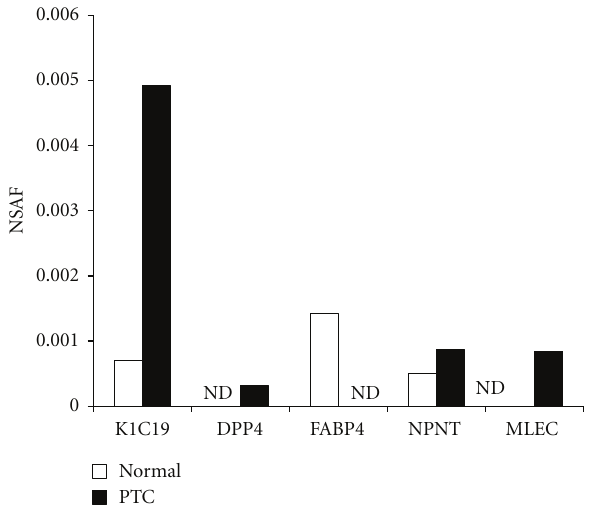
Figure 2: Comparison of NSAF in the identified proteins in PTC tissues ( n = 3) with NSAF in normal thyroid tissues ( n = 3). Similar to previous reports, Keratin 19 (K1C19) and Dipeptidyl peptidase 4 (DPP4) were strongly expressed in PTC, and Fatty acid-binding protein 4 (FABP4) was strongly expressed in normal thyroid tissues. NPNT and MLEC were discovered as strongly expressed candidate markers in PTC (Normal: normal thyroid tissue, PTC: Papillary thyroid carcinoma, ND: not